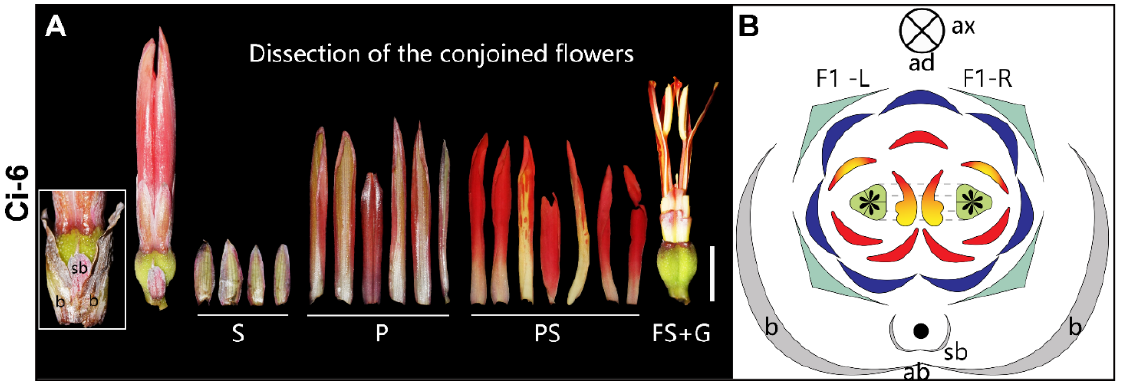
Figure 9. 2-flowered thyrse. ( A ) Photograph and ( B ) diagram of the partial inflorescence of Ci-6. Dashed line in (B) indicates the ovaries are fused. Bar = 1 cm. Dashed line in ( B ) indicates the ovaries are fused. Bar = 1 cm.